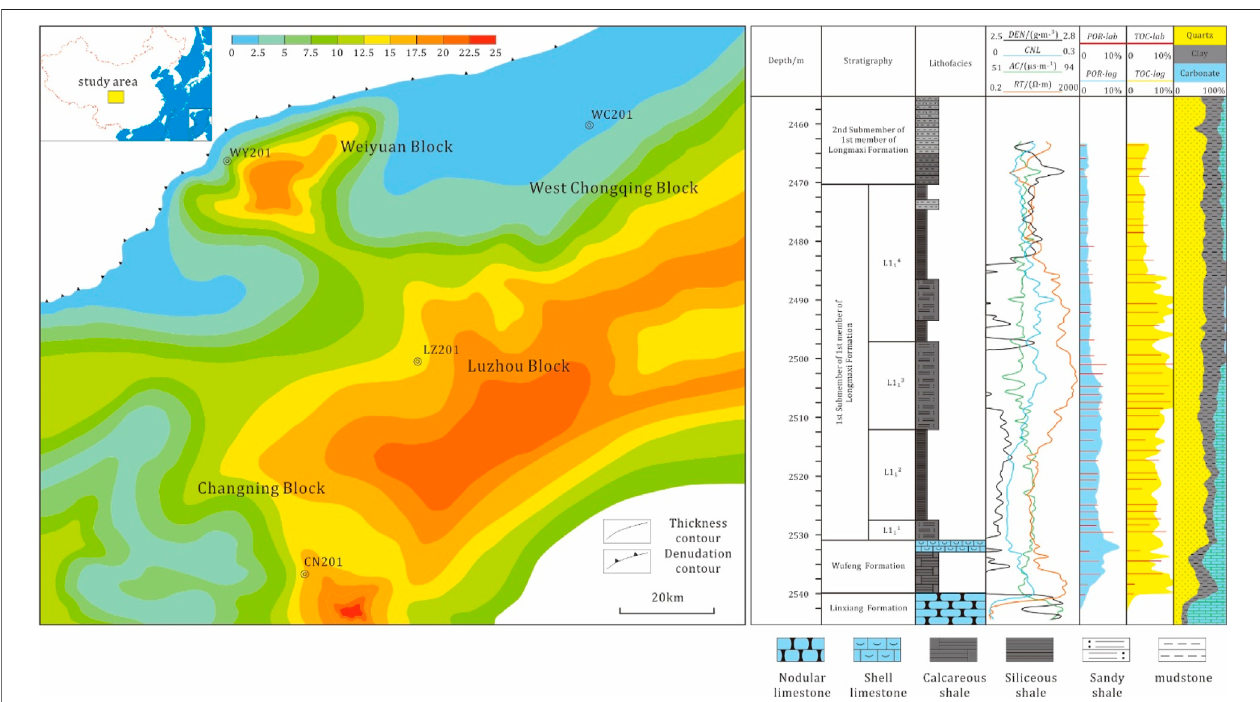
FIGURE 1 | Map showing the high-quality reservoir thickness of the 1st member of Longmaxi Formation, and locations of sampling well and its comprehensive stratigraphic column.